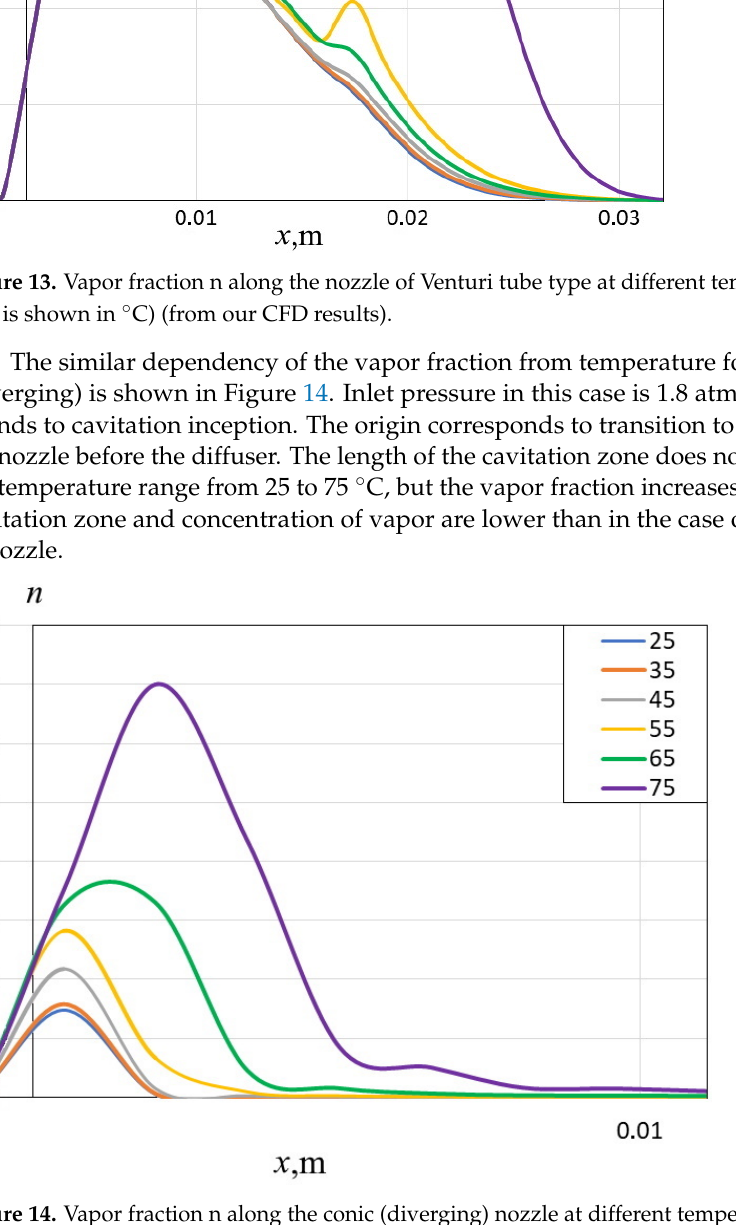
Figure 15. Vapor fraction n along the cylindrical nozzle at different temperatures (temperature is shown in °C) (from our CFD results). In general, all physical values in Equation (1) have some relationship with tempera- ture. The growth of vapor pressure p v and decrease of density ρ of the fluid will lead to a change of pressure p abs and velocity v in order for the cavitation number to reflect cavita- tion inception. This process is shown in Figures 16–18 where we analyzed how tempera- ture increase affects cavitation number. We can observe that the cavitation number de- creases at the increase of temperature as well as the critical cavitation number which de- scribes cavitation inception. For the Venturi tube type of nozzle (Figure 16) and conic noz- zle (Figure 17), we have points where the cavitation number is constant for any tempera- tures in the range of 25–75 ° С . For the conic nozzle (Figure 17) σ (25)/ σ ( Т ) has the maxi- mum for characteristic point d in the cavitation nozzle after the cavitation zone. A further